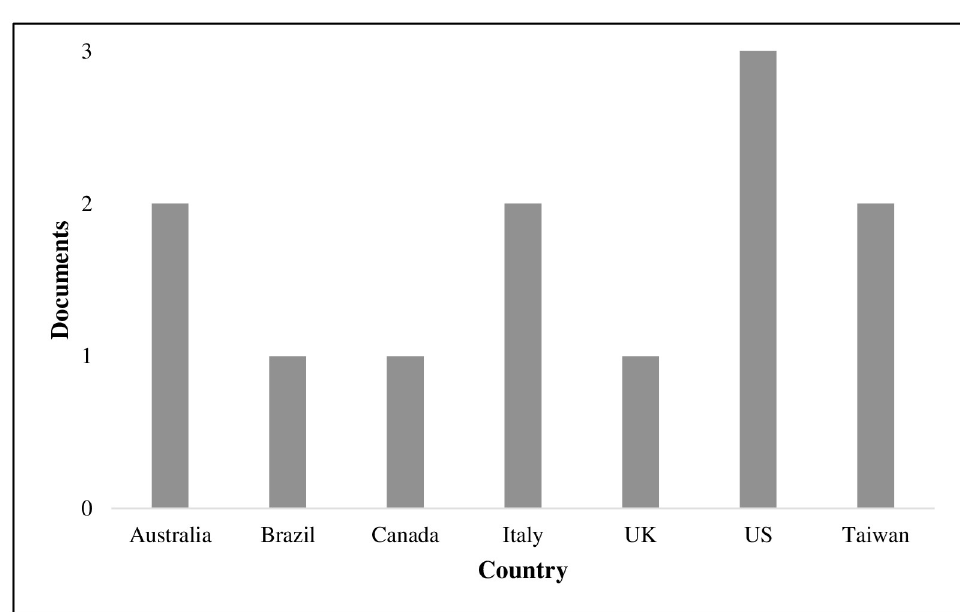
Fig 2. Distribution of published reviews by country.